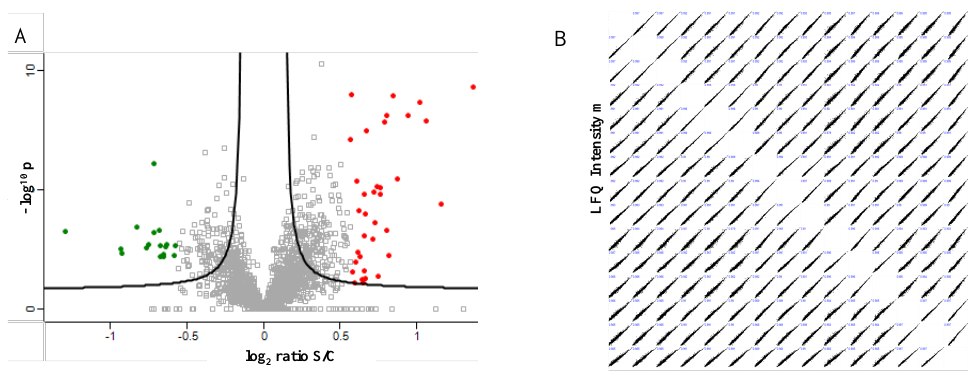
Figure 3. ( A ) Differentially regulated proteins in NAFLD (S), compared with control (C) resulted Figure 3. A) Differentially regulated proteins in NAFLD ( S ), compared with control ( C ) resulted from label free from label free analysis. Green represents downregulated proteins (log2 ratio ≤ − 0.5). Red represents analysis. Green colour are downregulated proteins (log2 ratio ≤ -0.5). Red colours are upregulated proteins (log2